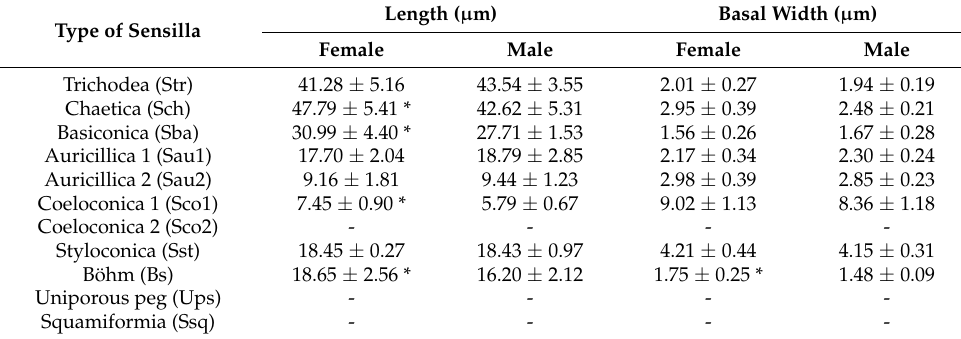
Table 1. Sizes of antennal sensilla of female and male T. rufivena . Type of Sensilla